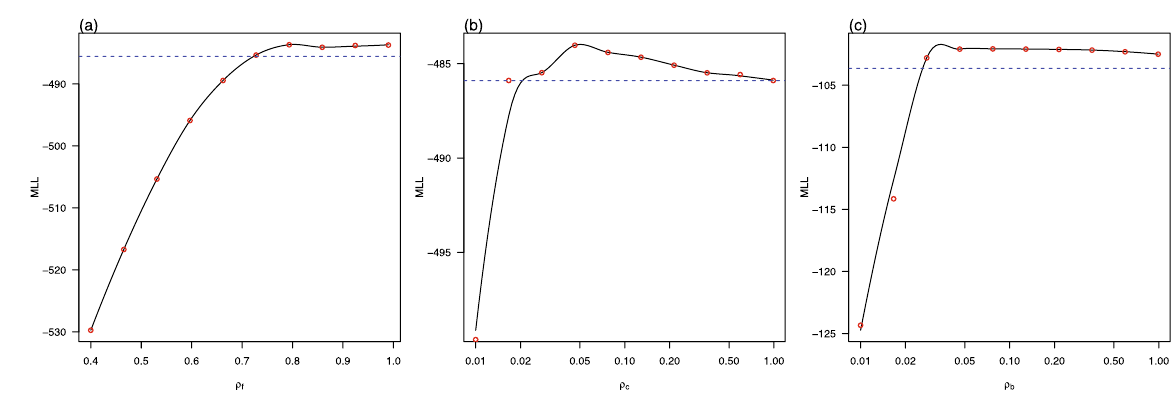
Figure 3. Maximum log-likelihood (MLL) as a function of parameter ξ i for ( a ) French Polynesia, ξ f ; ( b ) Colombia, ξ c ; and ( c ) the State of Bahia in Brazil, ξ b . The red circles denote the estimated MLL at the given value of the control parameter. The black curves denote Local Polynomial Regression Fittings with a span of 0.5. The 1 95,12 from the maximum of the MLL. The maximum value of the blue dotted lines indicate the thresholds of − χ . 2 0 black curve gives the maximum log-likelihood estimate of the control parameter, while the intersections of the two curves yield the 95% CI.